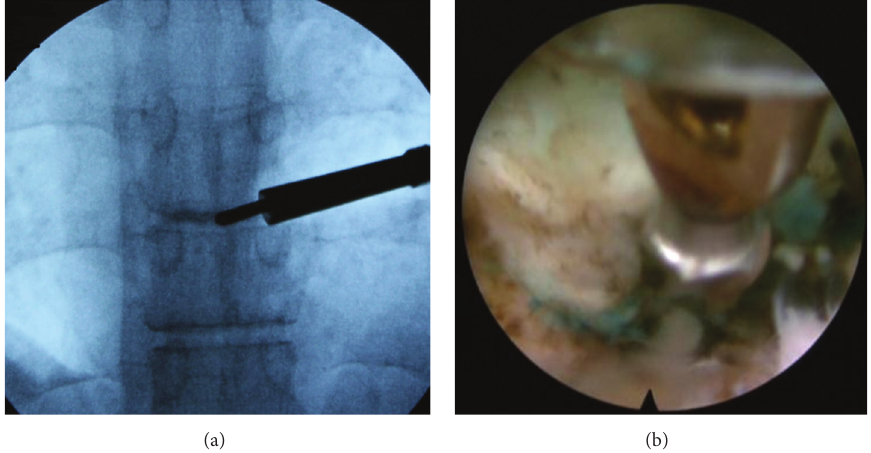
Figure 4: An Ellman radiofrequency probe (a) and a shaver (b) were used to expose the foraminal